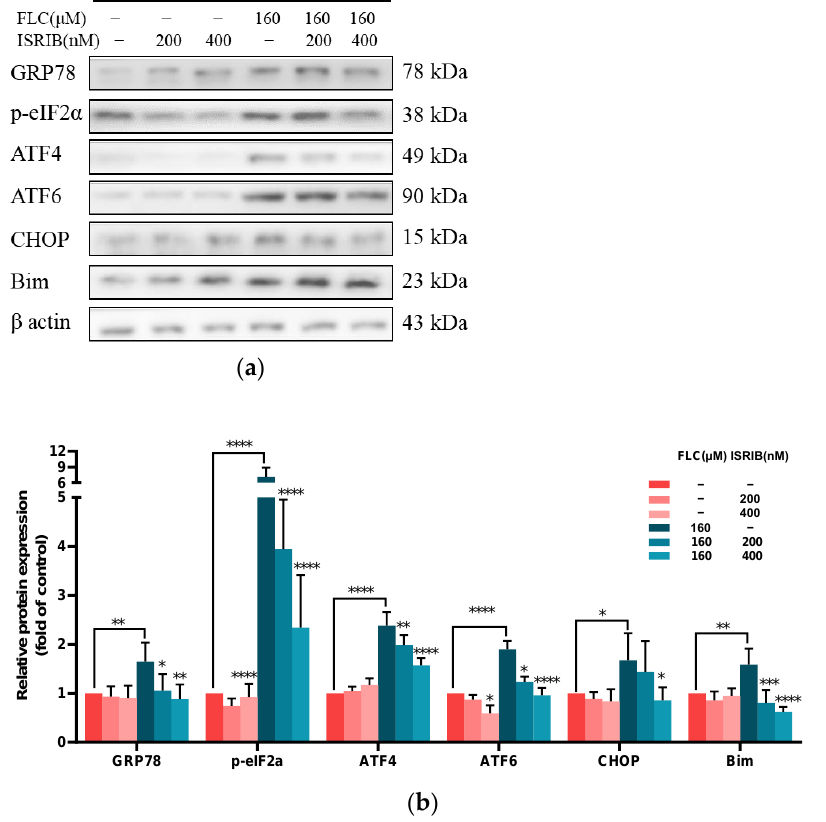
Figure 4. ISRIB inhibited UPR signaling pathways and ER stress. TM4 cells were treated by ISRIB at the concentration of 200, 400 nM for 6 h before treated by FLC at the concentration of 160 μM for 6 h. UPR and apoptosis related protein levels were determined by Western Blot with indicated antibodies. ( a ) The representative blots were shown; ( b ) The quantitative data was analyzed by ImageJ and GraphPad Prism software. * p < 0.05, ** p < 0.01, *** p < 0.001, **** p < 0.0001 vs. corresponding group, n = 6.